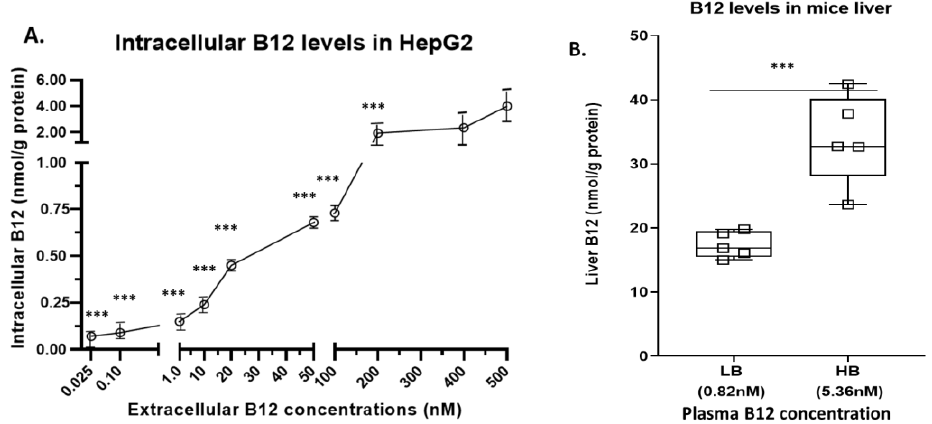
Figure 1. Intracellular B12 levels in Hep G2 cell line and mice liver corresponding to levels of B12 in circulation: ( A ) Hep G2 cell line was cultured in ten different concentrations of B12 (500 nM (control), 400 nM, 200 nM, 100 nM, 50 nM, 20 nM, 10 nM, 1 nM, 0.1 nM and 0.025 nM) in EMEM media. B12 levels in Hep G2 cell line lysates ( n = 6) were measured. ( B ) Liver tissues of both high plasma B12 (HB) group (5.36 nM) and low plasma B12 (LB) group (0.82 nM) mice were homogenized in 500 µ L of PBS and the B12 of lysate and plasma were measured. The data is representative of mean ± SEM ( n = 6), * indicates significance compared to the control; *** p <